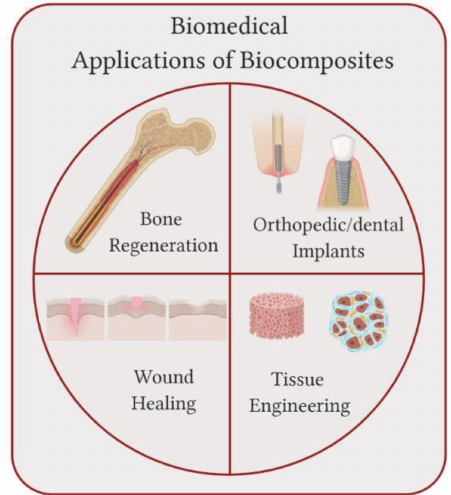
Figure 1. Biomedical applications of biocomposites: biocomposites can be applied to bone regeneration, orthopedic implants, wound healing patches and to tissue